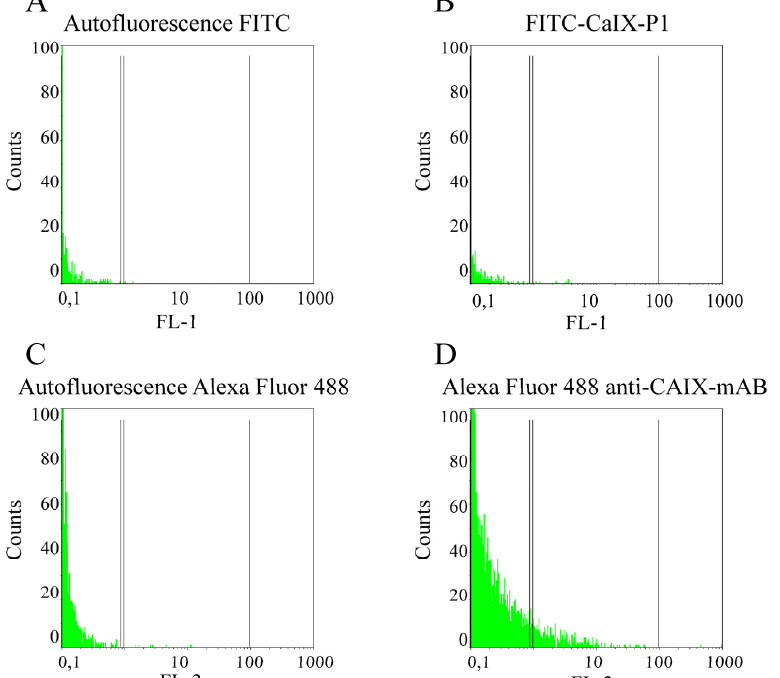
Figure 10. Fluorescence-activated cell sorting analysis. ( A ) Autofluorescence of BxPC3 cells at 530nm (FL1). ( B ) Fluorescence of BxPC3 cells after incubation with FITC-CaIX-P1. ( C ) Autofluorescence of BxPC3 cells at 488nm (FL3). ( D ) Fluorescence of BxPC3 cells after incubation with Alexa Fluor-labeled